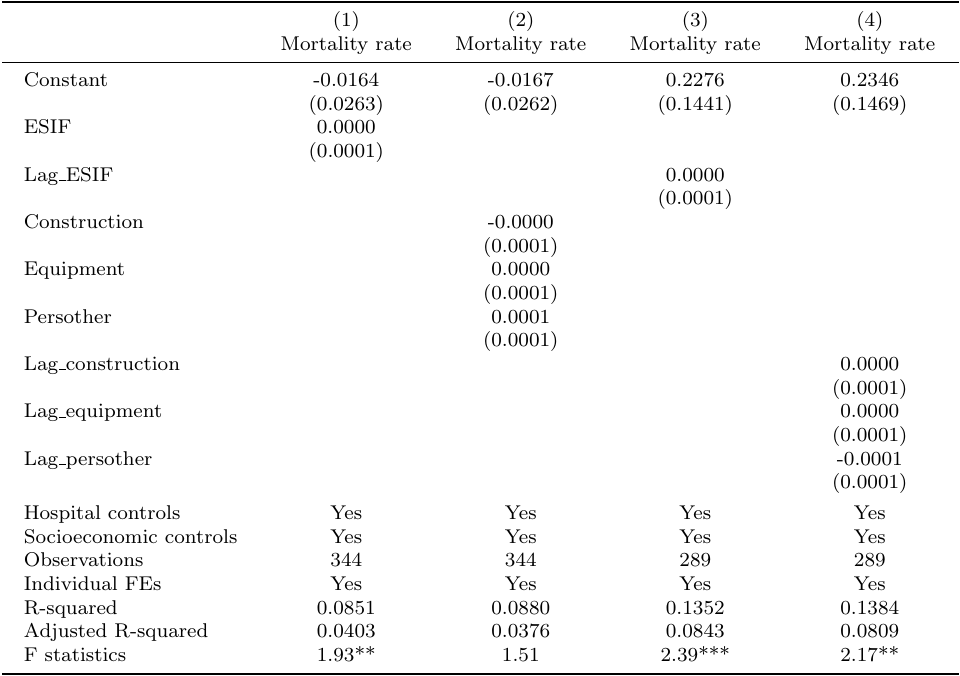
Table 5: Contemporaneous and lagged effects of cumulative ESIF on the mortality rate (1) (2) (3) (4) Mortality